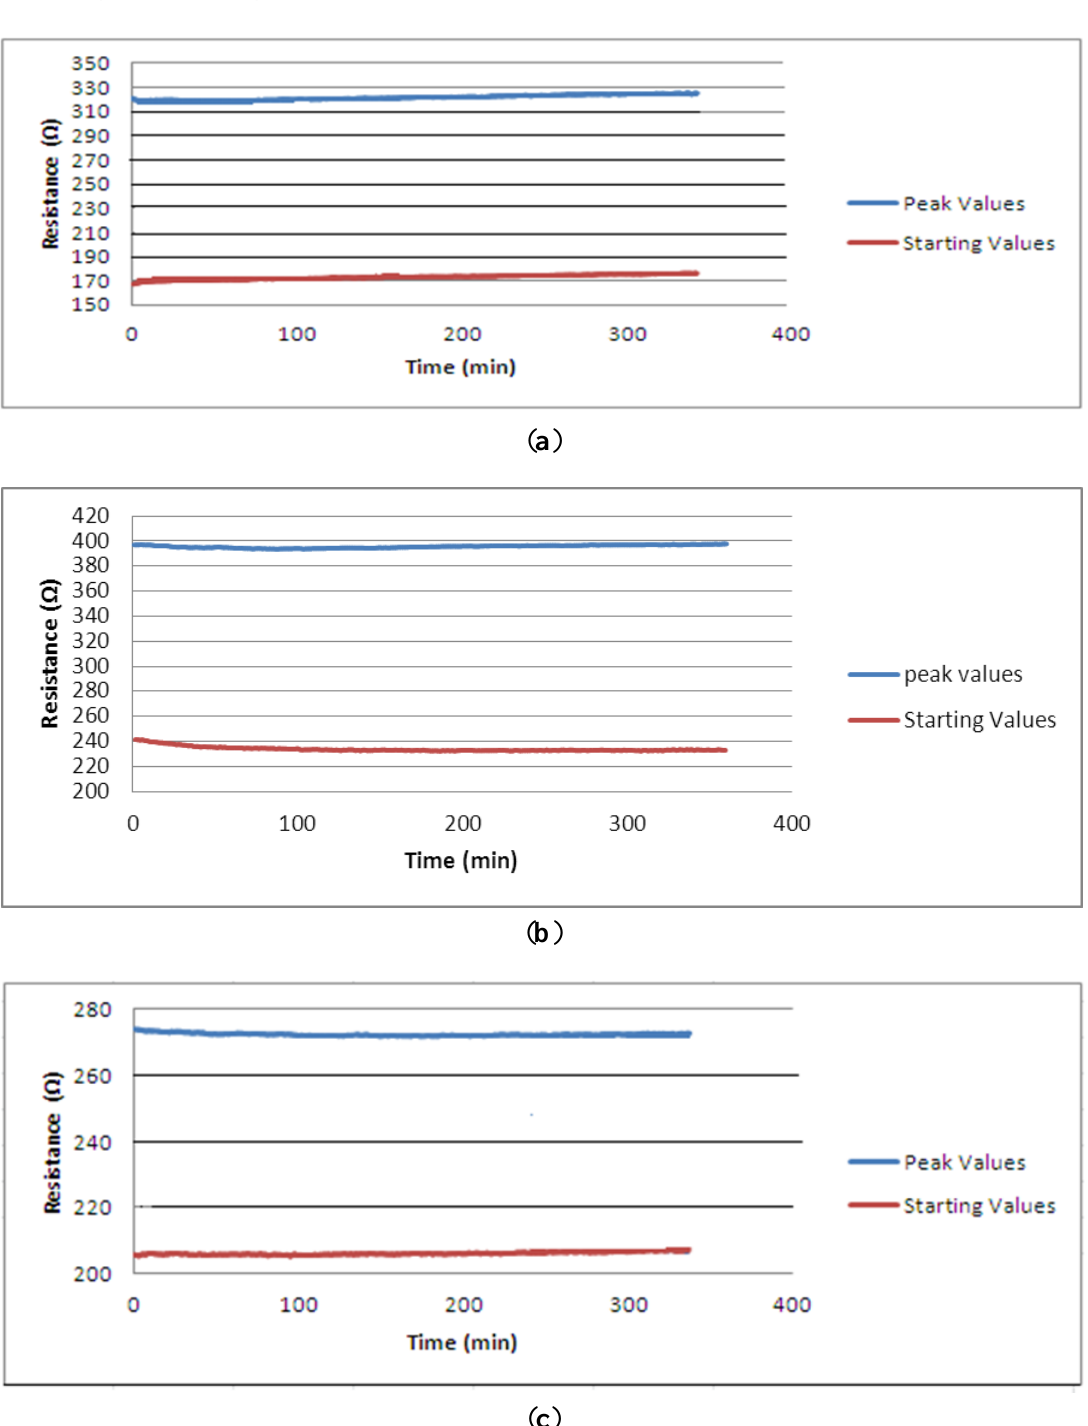
Figure 8. Long term cycling behaviour graphs of three group sensors: ( a ) Group 1; ( b ) Group 2; ( c ) Group